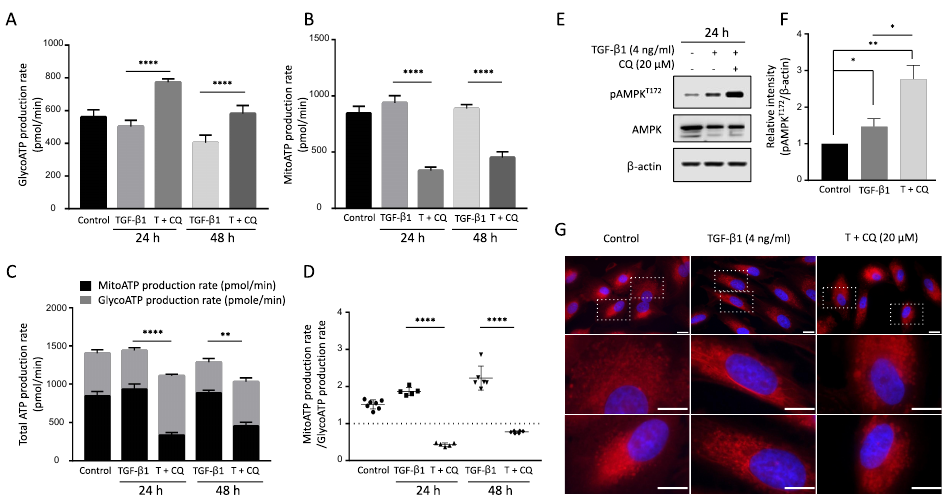
Figure 6. Inhibition of autophagy in TGF- β 1 treatment decreased ATP production in mitochondria. Real-time ATP rate assay by Seahorse XF analyzer. A549 cells were incubated with TGF- β 1 4 ng/mL with or without 20 µ M chloroquine for 24 h and 48 h. The ATP production was distinguished by ATP production rate via ( A ) Glycolysis and ( B ) Mitochondria (OXPHOS). **** p < 0.0001 were determined by two-way ANOVA followed by Tukey’s test. ( C ) Total ATP production. The summary of ATP produced from Glycolysis and Mitochondria. ( D ) ATP rate index. The ratio between ATP production from Mitochondria to ATP production by glycolysis. ** p < 0.01, **** p < 0.0001 were determined by two-way ANOVA with Tukey’s test. ( E ) Western blotting assay of p-AMPK T 172 and AMPK protein level in TGF- β 1 treatment with or without Chloroquine. ( F ) The relative intensity of p-AMPK T 172 to β -actin. ( G ) Mitochondria staining. A549 cells were incubated in the presence of TGF- β 1 with or without Chloroquine treatment. Then, mitotracker deep red was used to stain mitochondria. Bar, upper 10 µ m and bottom 20 µ m. Data represent the mean ± s.d of three independent experiments. * p < 0.05 to control was determined by one-way ANOVA followed by Tukey’s test. ns indicates not significant p